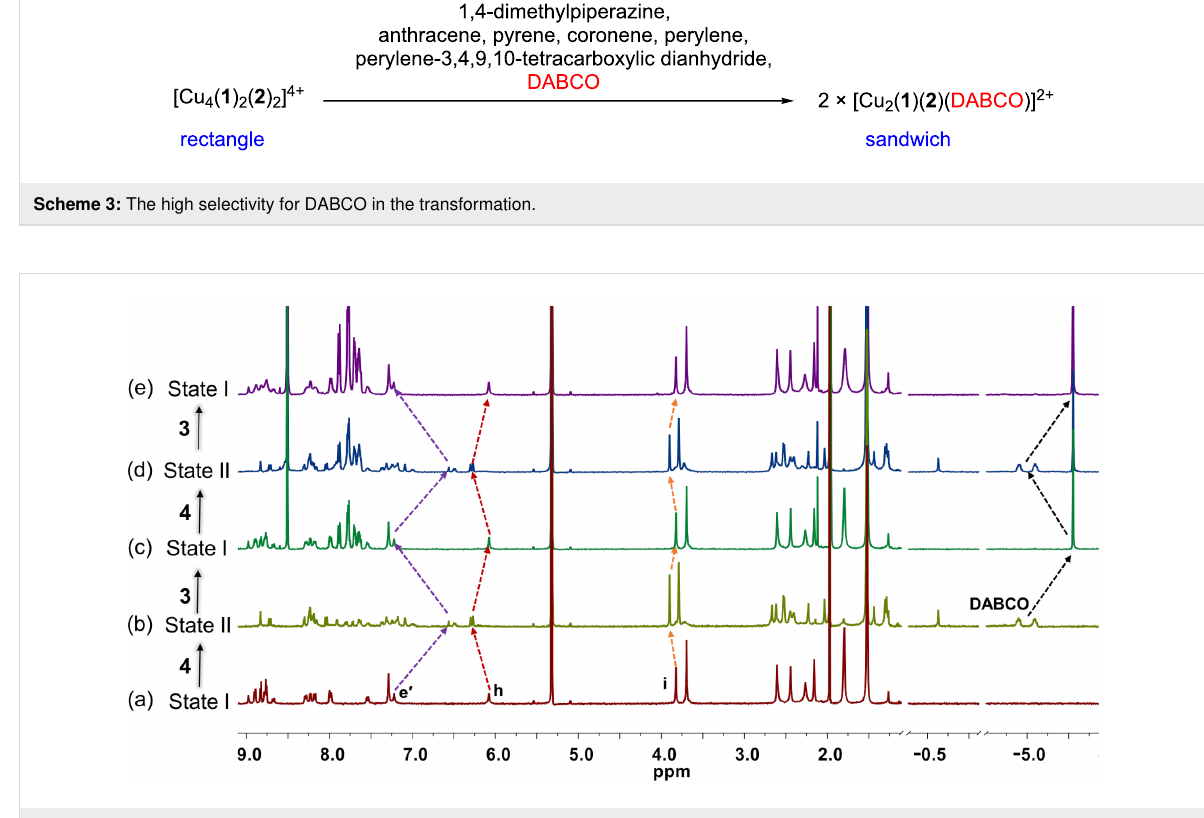
Figure 4: Partial spectra (400 MHz, CD 2 Cl 2 , 298 K) showing the reversible switching between rectangle and sandwich complexes over 2.0 cycles; (a) after mixing of [Cu(CH 3 CN) 4 ]PF 6 , 1 , and 2 in 2:1:1 ratio, furnishing rectangle 5 (state I); (b) after adding 2.0 equiv of DABCO, furnishing sandwich complex 6 (state II); (c) after addition of 4.0 equiv of rhodium porphyrin 3 , leading to formation of rectangle 5 and rhodium porphyrin dimer 7 . (d) Further addition of 2.0 equiv of DABCO furnishes state II; (e) finally, addition of 4.0 equiv of rhodium porphyrin 3 recovered rectangle 5 along with 4.0 equiv of complex 7